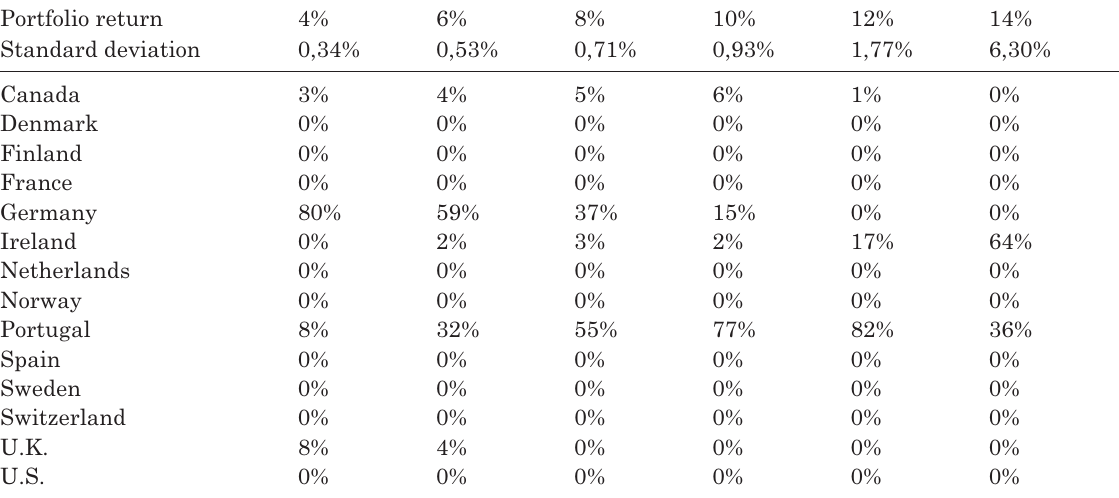
Table 9. Asset allocation in effi cient international real estate portfolios (unhedged returns) Portfolio